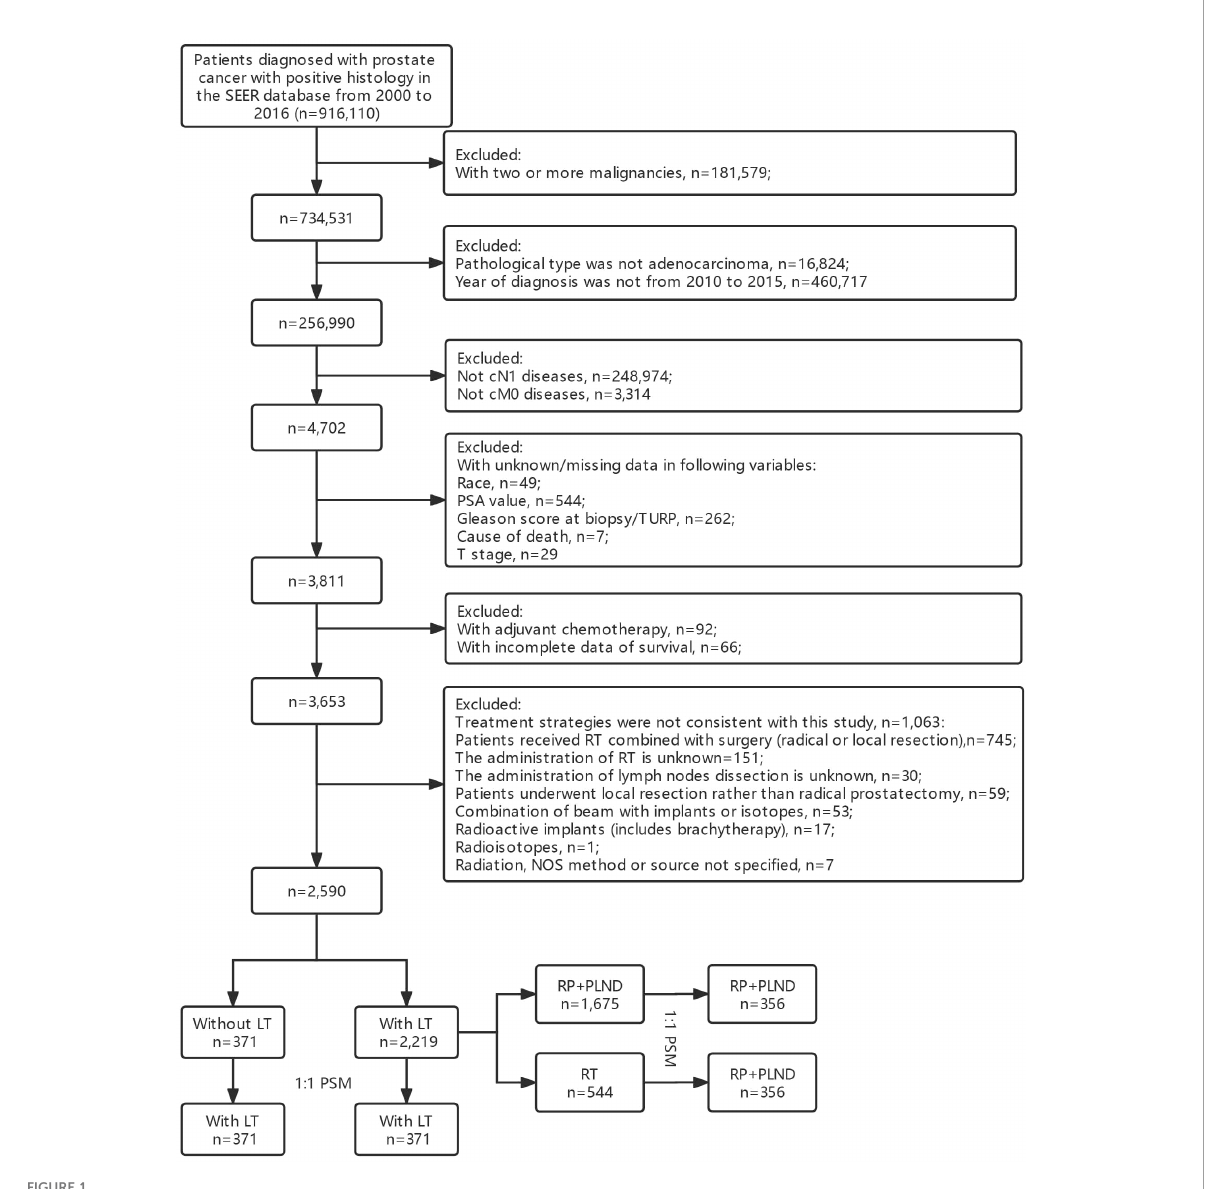
FIGURE 1 Flowchart of patient